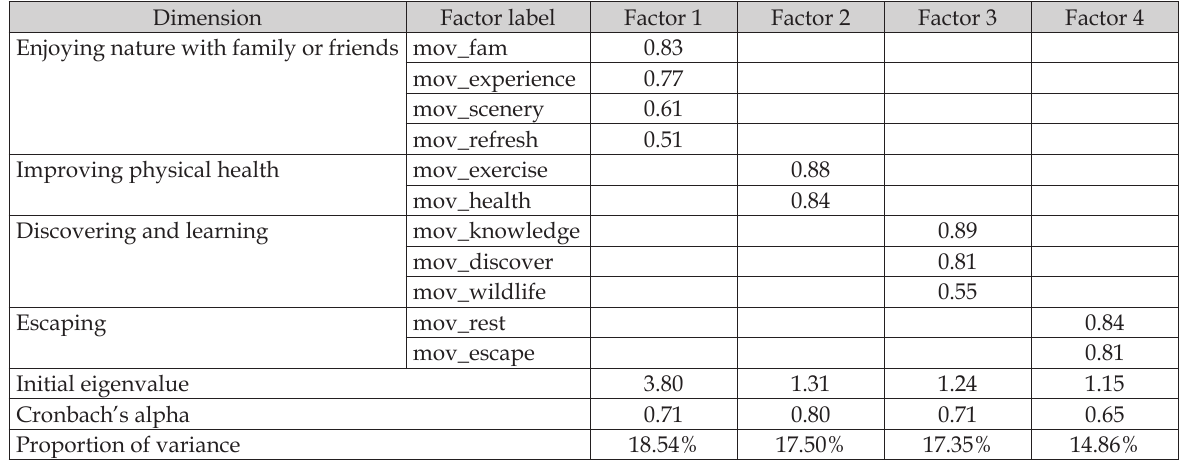
Table 2. Principal-component factor analysis of push factors. Source: own study.